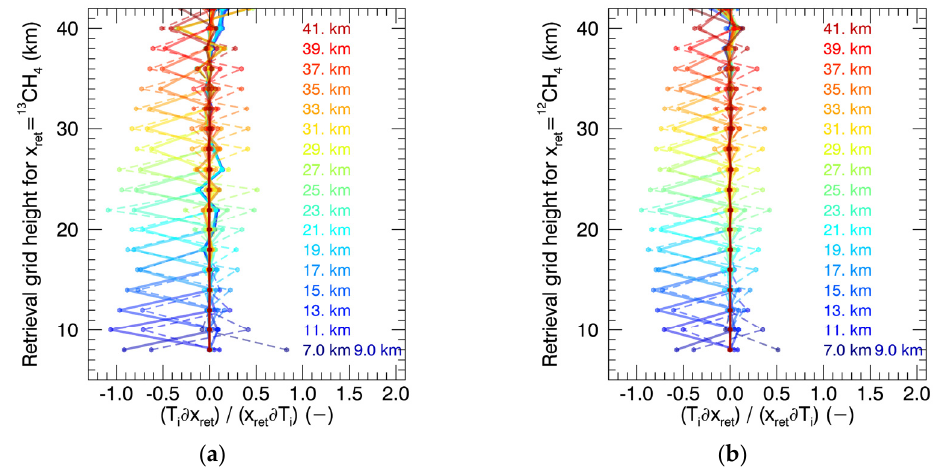
Figure 10. Temperature sensitivity of: ( a ) the 13 CH 4 ; and ( b ) the 12 CH 4 retrieved profiles ( x ret = ˆ x ). In both cases, the retrieval grid is spaced every 2 km, the (perturbed) parameter grid every 1 km. The same colour is used for a perturbation at the same height as the retrieval height (solid lines) and the level 1 km above (dashed lines). The height (as text) of these intermediary levels is written out at the retrieval height where the sensitivity to the perturbation is largest. The horizontal axis is given as a relative change in the retrieved state vector element per relative change (e.g., 1%) of temperature at the specified level.